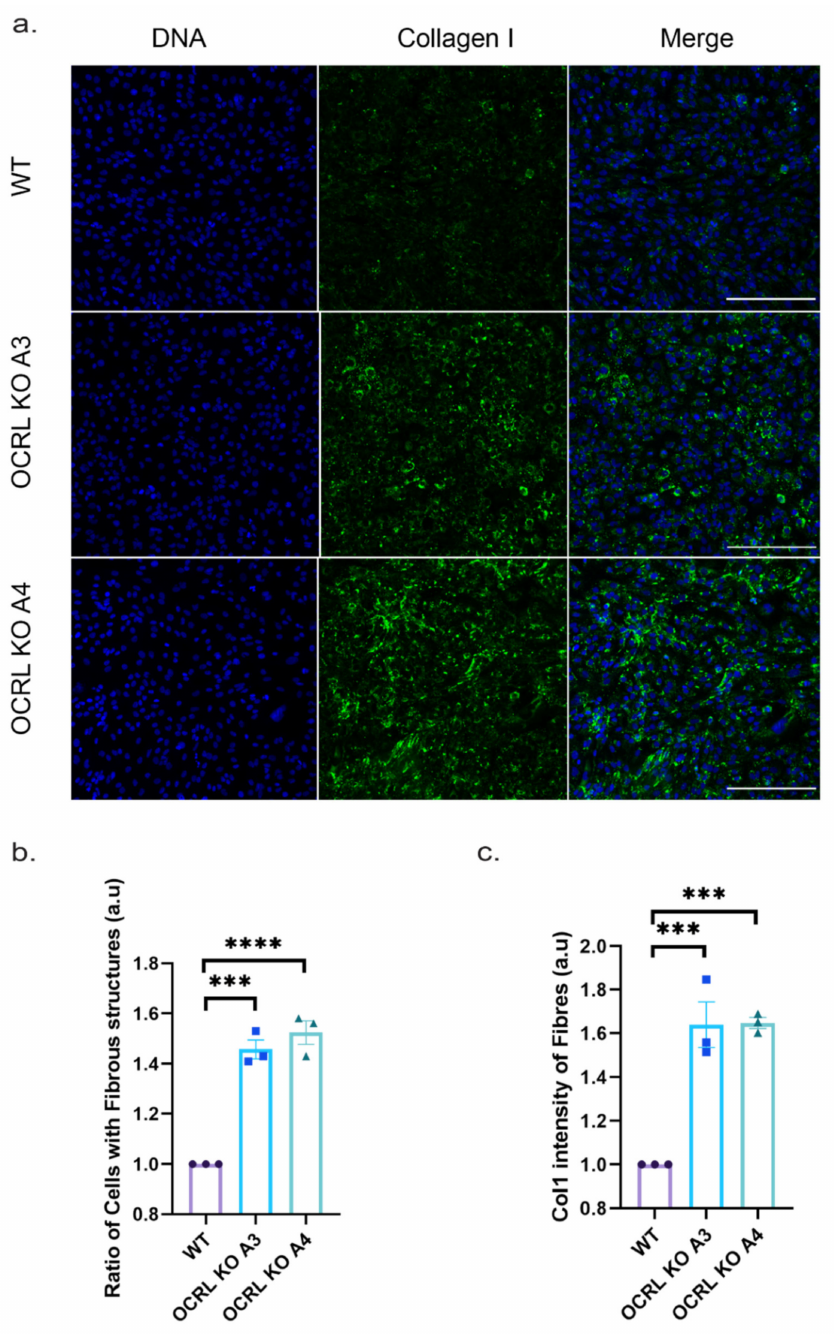
Figure 8. Collagen deposition: ( a ) 2D experiment: Immunofluorescence images captured by an InCell 6000 when cells were cultured for 7 days and stained with Col 1 antibody without permeabilising the cells to stain for ECM deposition (green). Scale bar: 5 µ m. ( b ) 2D experiment: Graph showing increased ratio of cells with fibrous structures in OCRL KO cells when stained for collagen. ( c ) 2D experiment: graph showing increased collagen fibres deposited on OCRL KO cells measured by normalising the collagen staining intensity by the number of cells. Ordinary one-way ANOVA and Dunnett’s multiple comparison test, N = 3 (>50 cells per N), ***, p < 0.001; ****, p < 0.0001, error bar represents the mean with ±